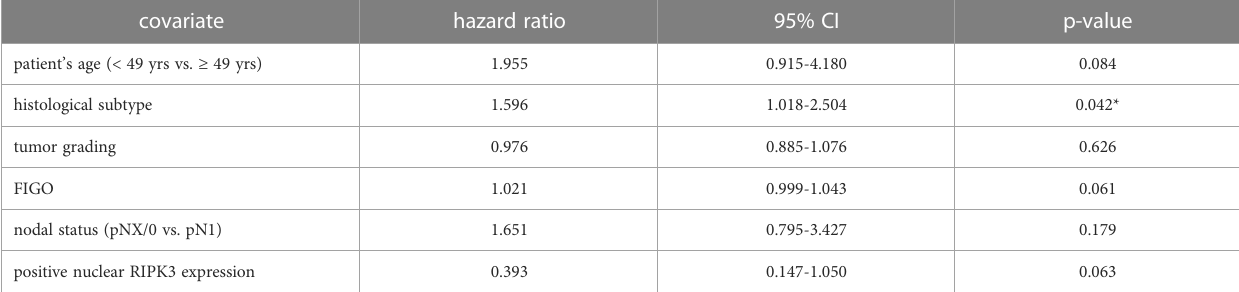
TABLE 5 Multivariate Cox regression analysis of cervical cancer patients ( n = 250) and their clinical and pathological characteristics including nuclear RIPK3 expression regarding OS. covariate